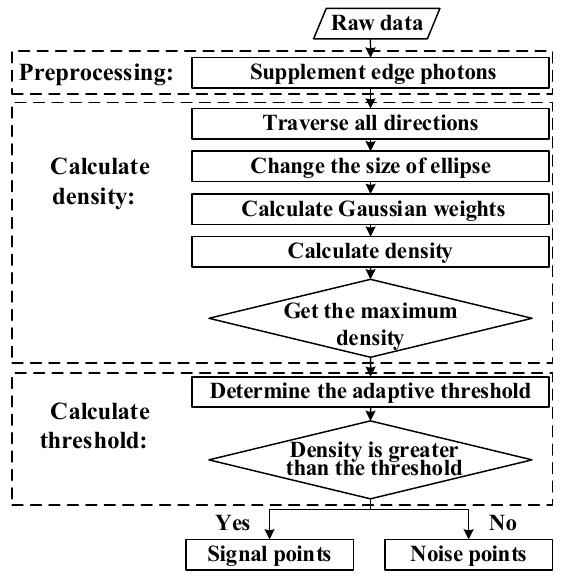
Fig 1. The flow chart of the elliptical Gaussian density adaptive filter method